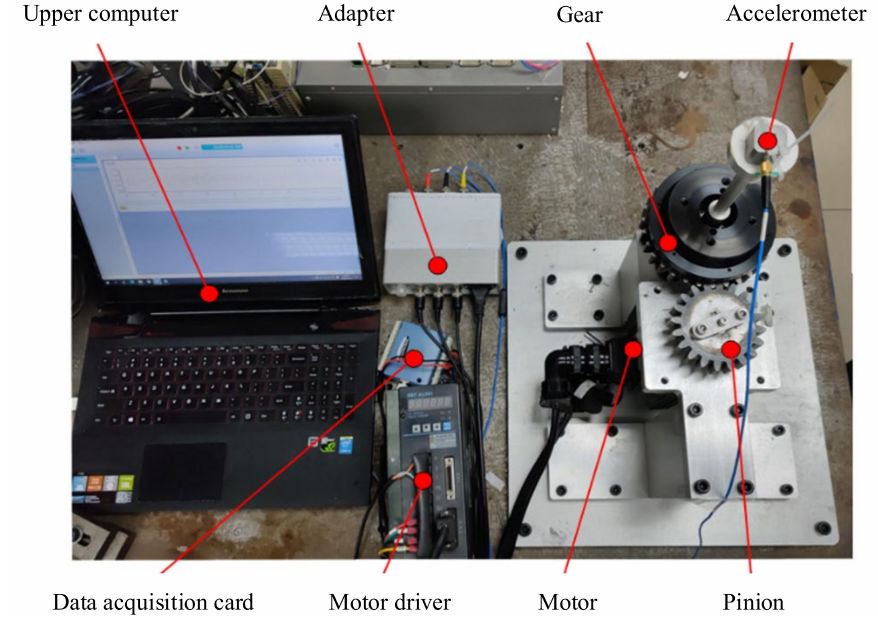
Figure 9. Experimental setup of gear